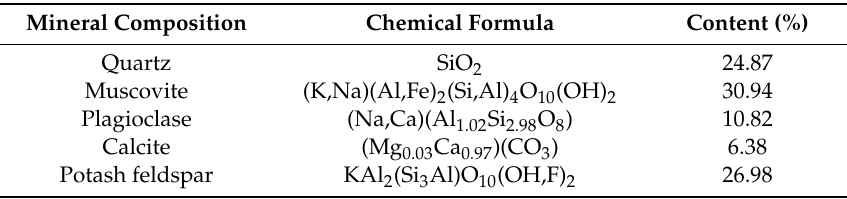
Table 6. Mineral composition content of